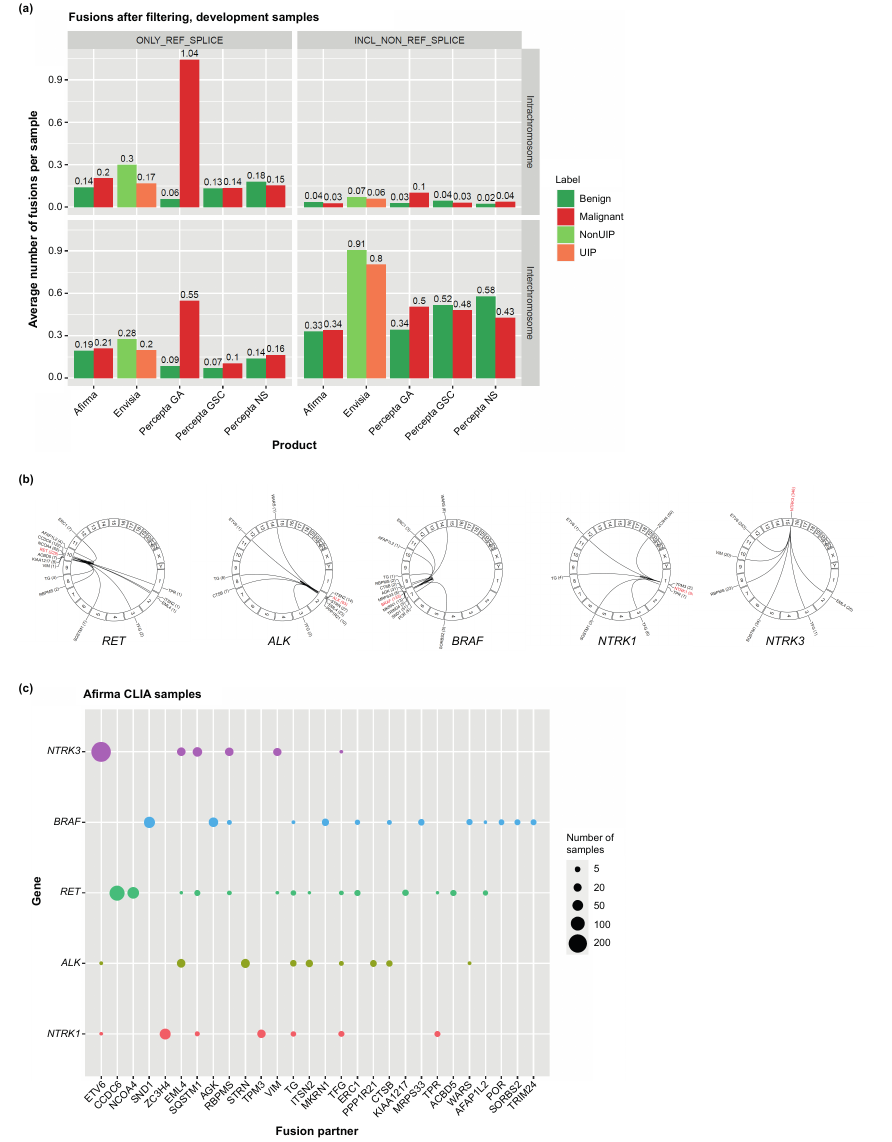
Figure 2. Fusion discovery across Unified Assay samples. ( a ) Number of fusions identified per sample across thyroid (Afirma), ILD (Envisia), and lung (Percepta) samples; ( b , c ) canonical fusions identified in thyroid Afirma CLIA samples. The following fusion calls were filtered out: having <3 junction reads; involving HLA, hemoglobin, or mitochondrial genes as one or both fusion partners; being between two immunoglobulin genes; and being called in >10% of samples from any one product with CLIA samples. ONLY_REF_SPLICE = having both splice sites matching a known reference splice site. INCL_NON_REF_SPLICE = having one or both splice sites not matching a known reference splice site. CLIA, Clinical Laboratory Improvement Amendments; GA, Genomic Atlas; GSC, Genomic Sequencing Classifier; HLA, human leukocyte antigen; NS, Nasal Swab; UIP, usual interstitial pneumonia; XA, Expression